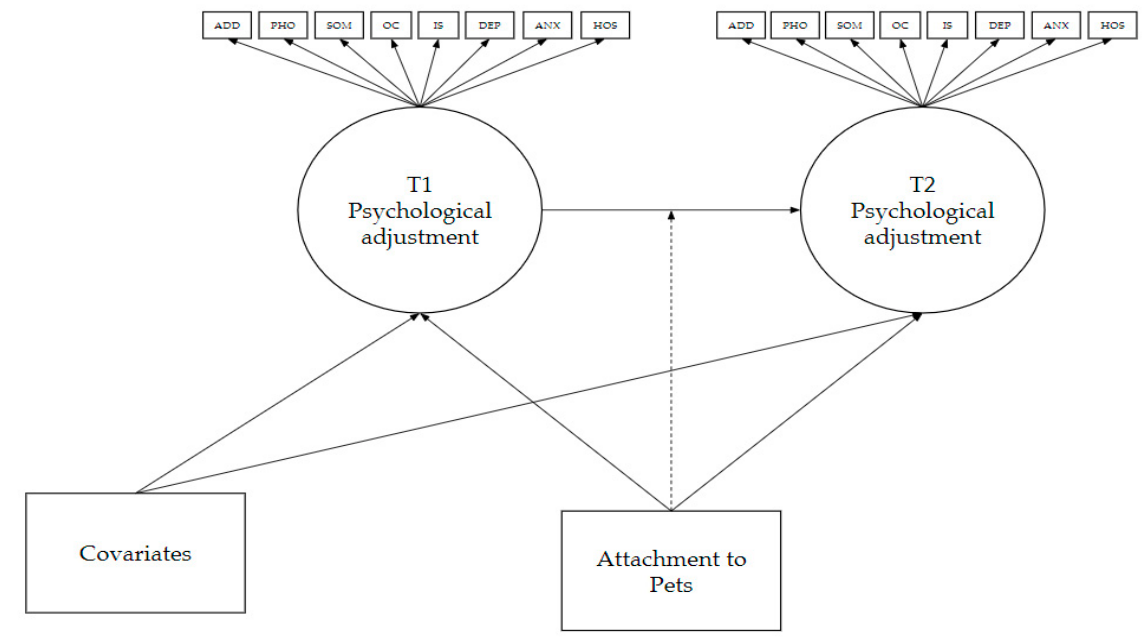
Figure 1. Analytic Model.